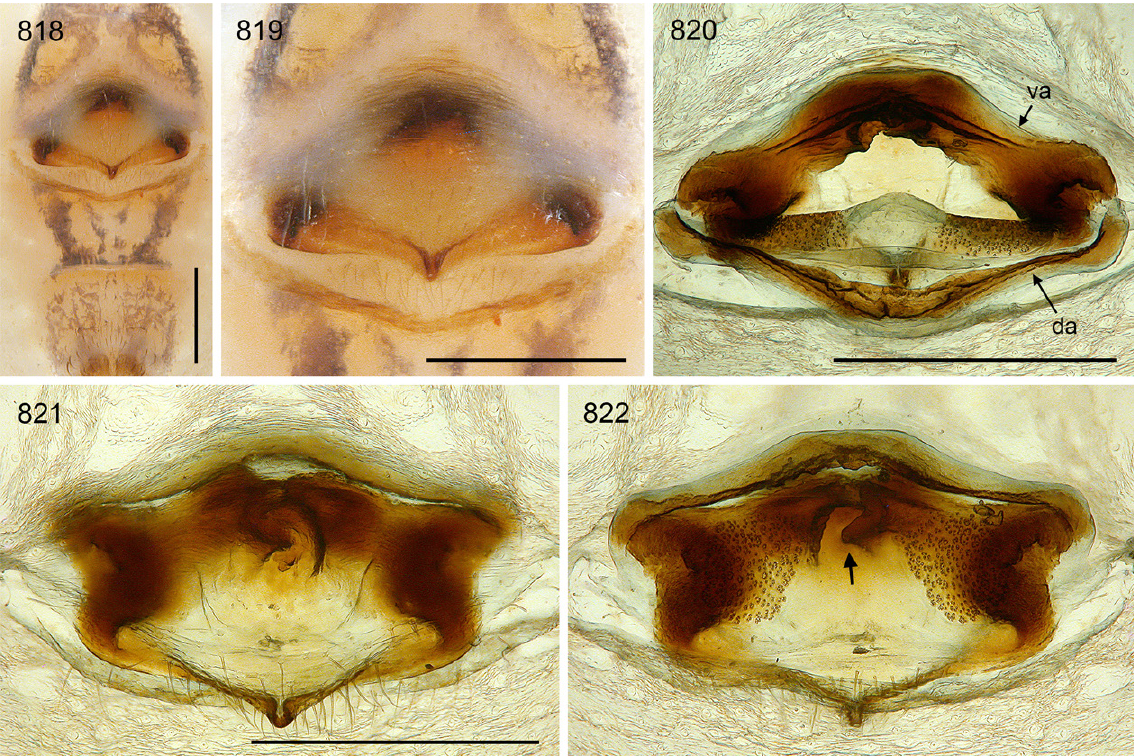
Abbreviations: da = dorsal arc; va = ventral arc. Scale bars = 0.5